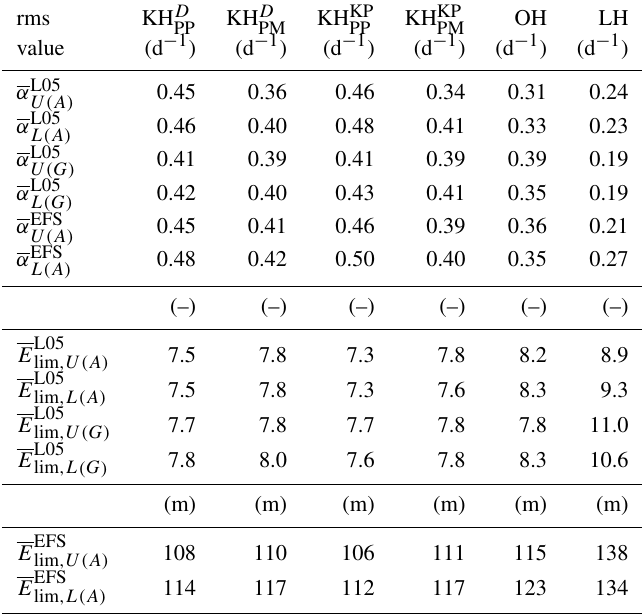
Figure 1. Comparison of upper-bound predictability curves E norm ,U of the ECMWF forecasting system normalized by E EFS ∞ annual arithmetic means, representative samples from 1986–2011) and the L05 system normalized by E L05 ∞ 1986–1999, arithmetic means 2000–2011). Table 3. The rms values calculated over all initial errors used for the L05 system ( N = 90) and over all years for the ECMWF forecasting system of parameters α and E lim (for description see Table